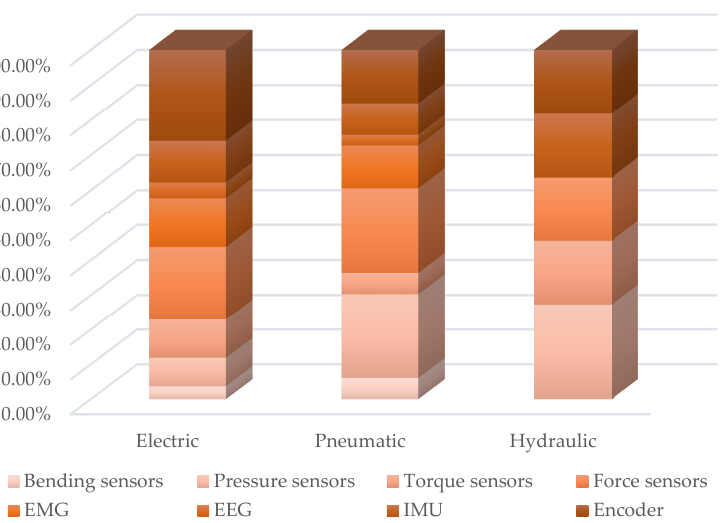
Figure 28. The distribution of the sensor types for the different power sources. With electric actuation, encoder (26%) and force sensors (21%) are the most used; EMGs, IMUs and torque sensors follow with the percentages 14%, 12% and 11%, respectively. With pneumatics, pressure sensors and force sensors are equally frequent (25%), and IMUs follows with 15%. With hydraulics, pressure sensors are dominant with 27%, while force sensors, torque sensors, IMUs and encoders are equally present